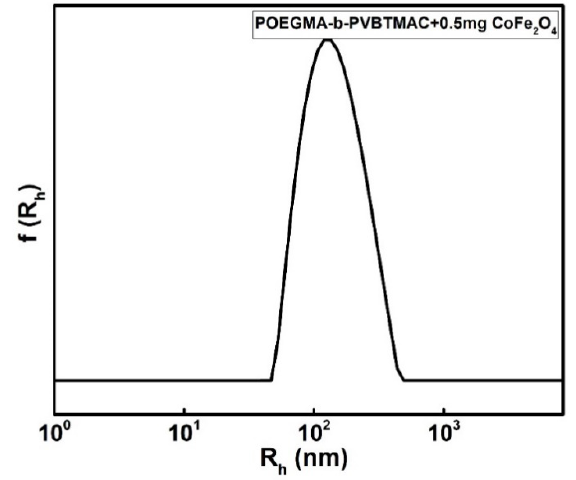
Figure 5. Size distribution from Contin for POEGMA- b -PVBTMAC/MNPs hybrid complexes at C = 5 × 10 −4 g/mL in aqueous solutions and